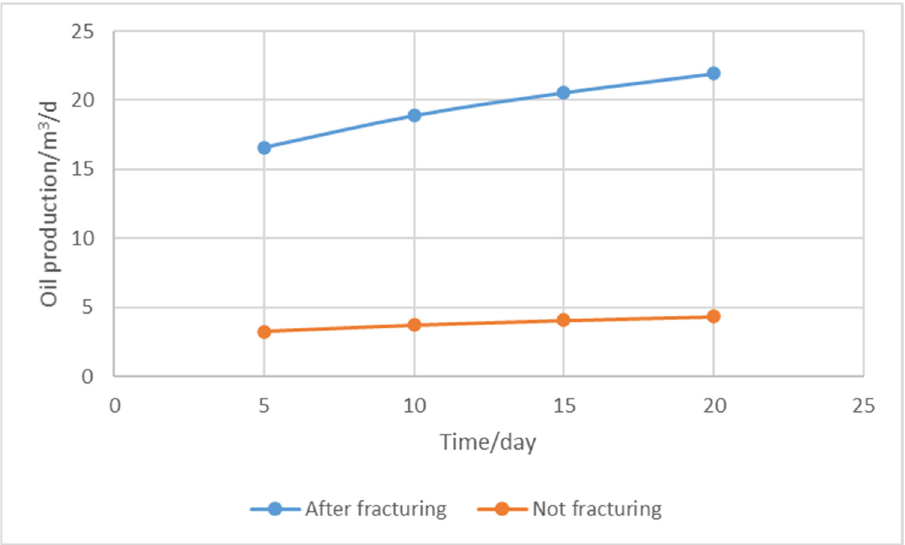
Figure 3. Fracturing affects production.